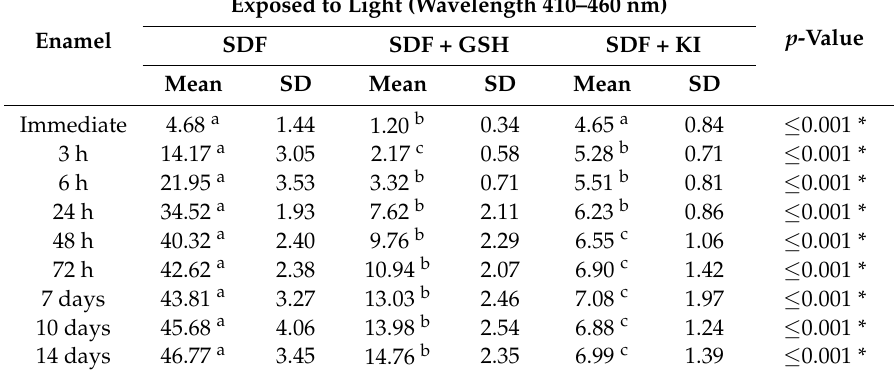
Table 1. Mean and standard deviation (SD) for the color change (ΔE) for different tested groups at all time intervals within enamel under light exposed conditions.